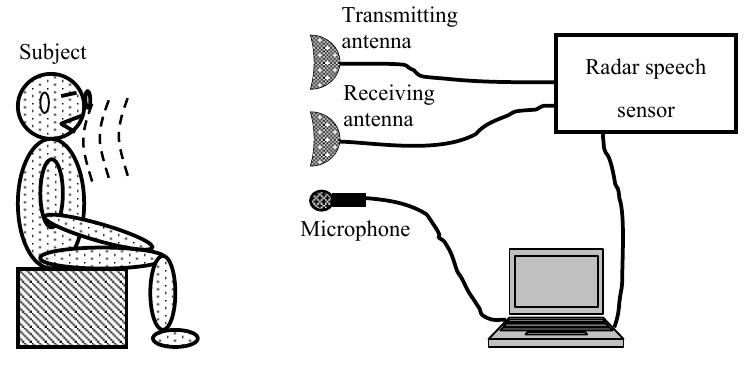
Figure 2. Diagram of experimental design for detecting speech